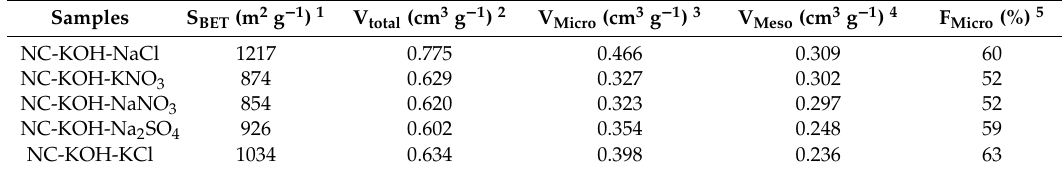
Table 6. BET surface area and porosity of samples activated by di ff erent salts.